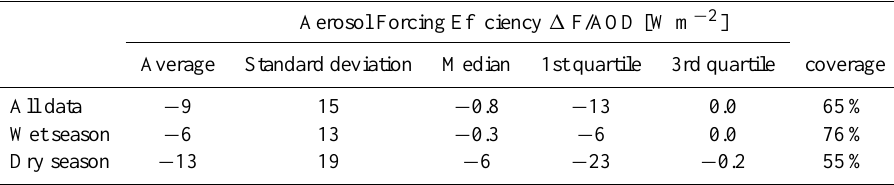
Table 7. Statistics for aerosol forcing efficiency at the top of the atmosphere calculated based on daily averages of scattering, backscatter ratio, absorption and cloud fraction (MODIS), enclosing the period between November 2009 and September 2010.